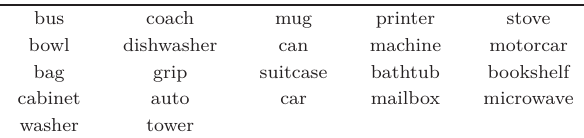
Table 1 ShapeNet 3D model categories used to render the target scene bus